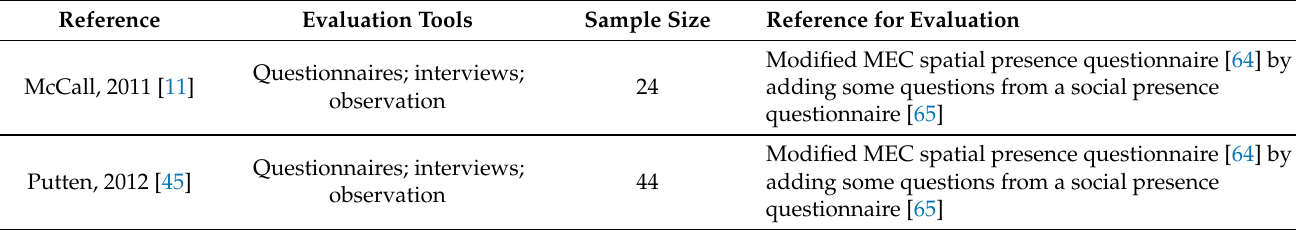
Table 5. List of evaluations conducted across the analysed